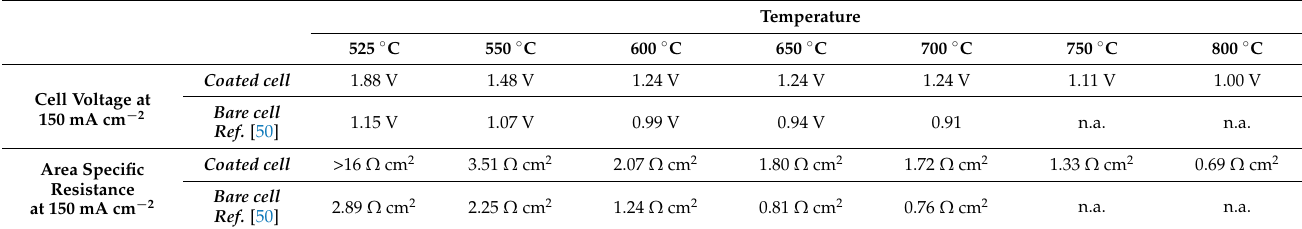
Table 1. Most relevant electrochemical results achieved with bare and coated cells.